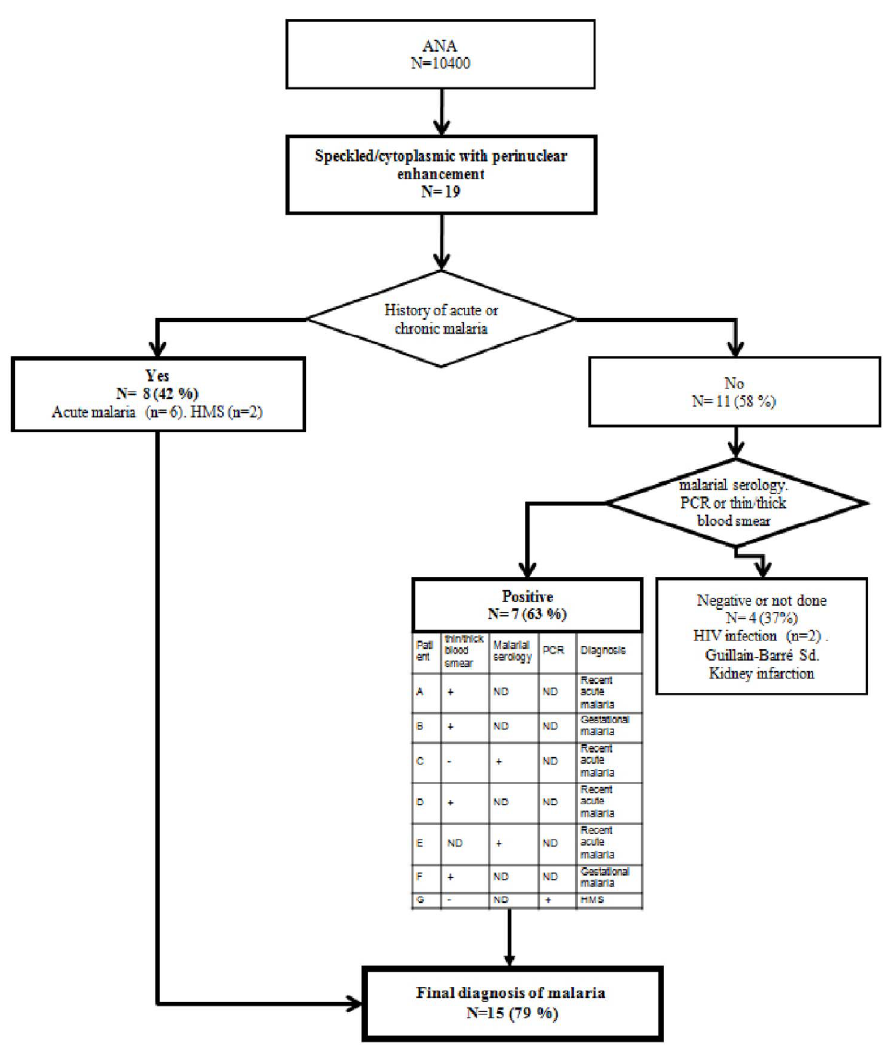
Figure 2. Nuclear speckled and cytoplasmic diffuse with perinuclear enhancement pattern is diagnostic for smoldering malaria. Occurrence or past history of malaria in patients with the distinct nucleo-cytoplasmic pattern was prospectively studied. The pattern was observed in 19 independent sera out of 10 400 ANA tests performed over a 12 month-period. For each patient, the occurrence of malaria was first searched in the medical clinical record file. If history of malaria was absent, serology, PCR or thin/thick blood smear were performed. Diagnosis for each case is indicated. (ND=not done).